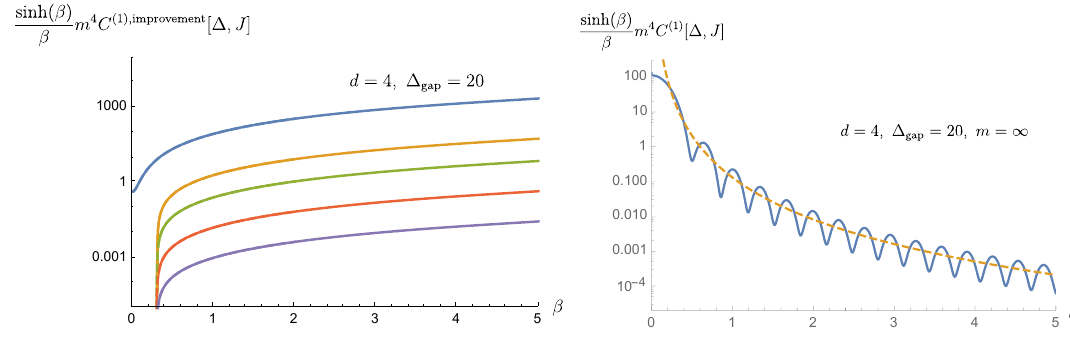
Figure 15. Contributions from the improvement (from top to bottom: m/ ∆ gap = 1 . 01 , 3 , 5 , 10 , 20 ) and unimproved (with m = ∞ ) terms for the AdS version of the flat space functional C (1) in (2.20). At large impact parameters β (cid:29) 1 / ∆ , the total functional ω (1) [∆ , J ] , is well approximated by gap AdS the sum of the two panels and is therefore positive (and qualitatively similar to figure 3). The dashed line on the right panel shows the Q contribution from formula (5.44). The width of the 3 peak in (b) is proportional to 1 / ∆ gap